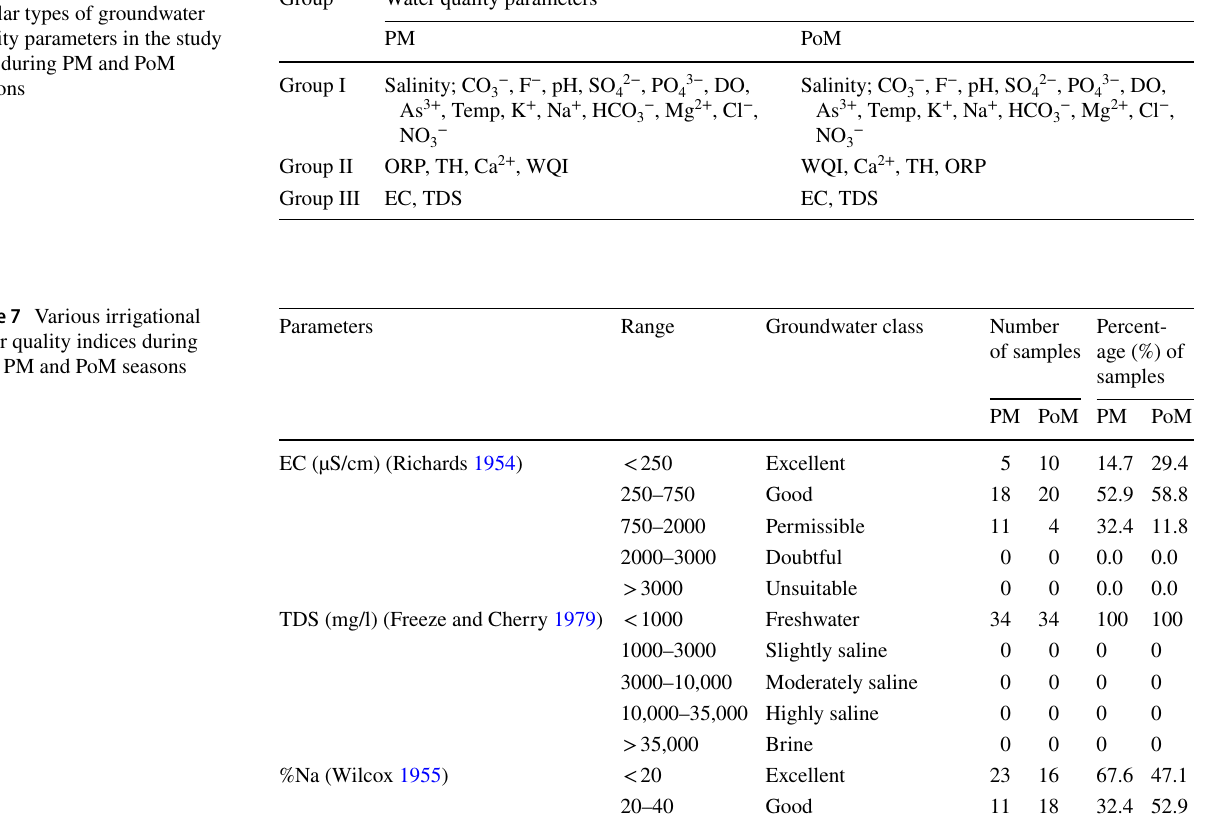
similar types of groundwater quality parameters in the study area during PM and PoM seasons